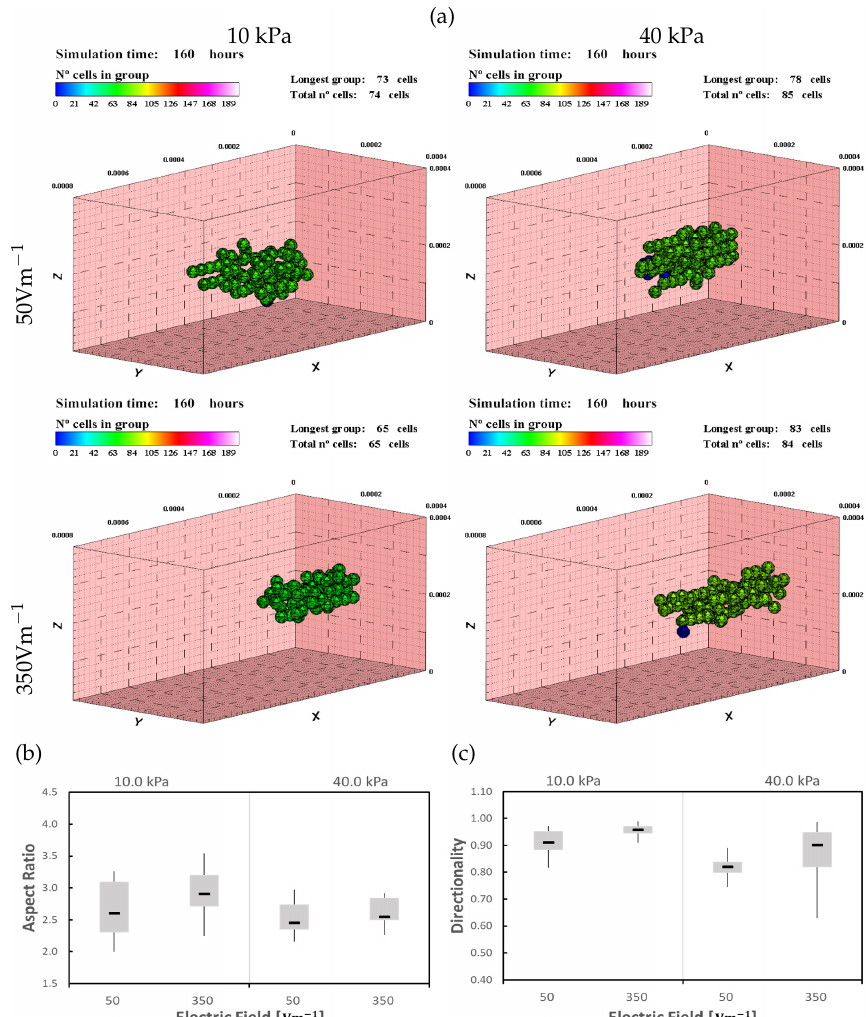
Figure 6. Cardiomyocytes (CMs) in 10 and 40 kPa ECMs, under ES of 50 and 350 Vm − 1 , after 160 h of simulation (see also Supplementary Materials video 1). ( a ) Cells tend to form a longer group in the longitudinal direction as the electric field increases. Under low electrical stimulus (50 Vm − 1 ), cells remain at the center of the ECM (top). As the stimulus increases, cells tend to move to the outer surface of the ECM (bottom). Numerical results for Aspect Ratio (AR) ( b ) and directionality ( c